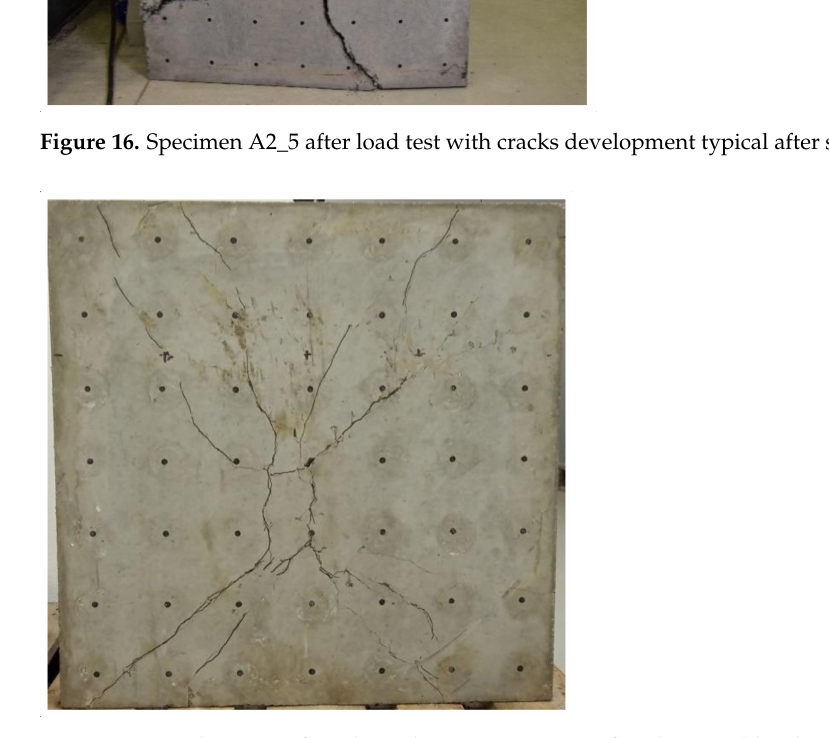
Figure 17. Development of cracks in the specimen A2_3 after dynamic blast load by 600 g